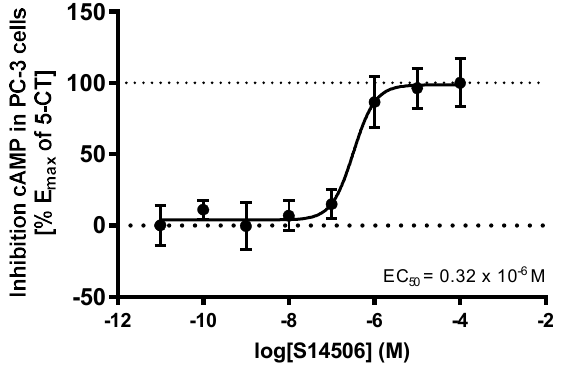
Figure 10. Influence of S14506 on the cAMP level in PC-3 prostate cancer cells (1 μM forskolin).